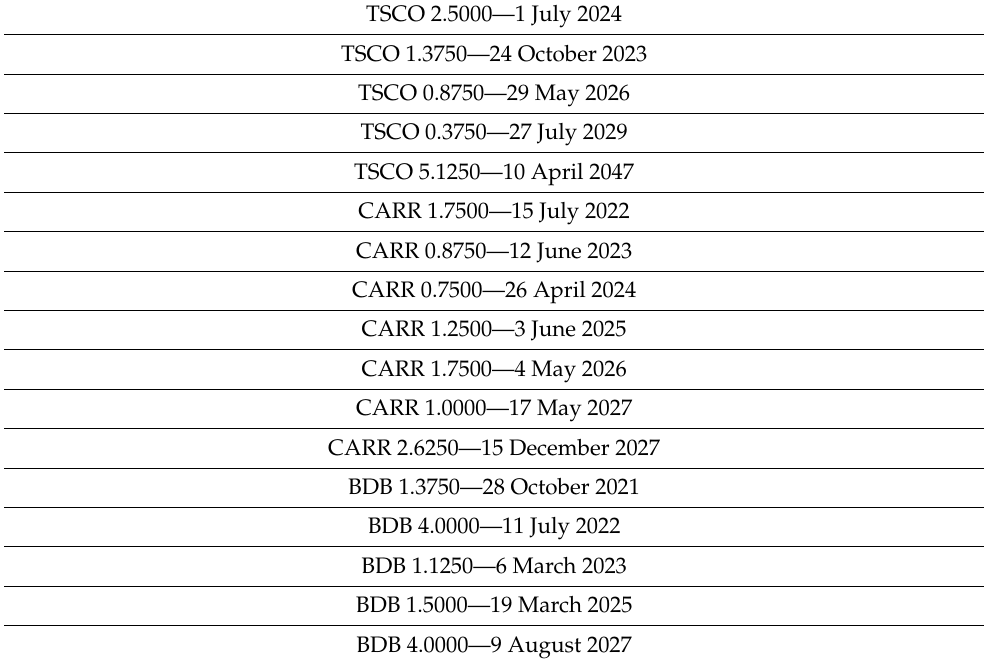
Table 2. All Euro-denominated issues of Tesco, Carrefour, and Metro as of 26 July